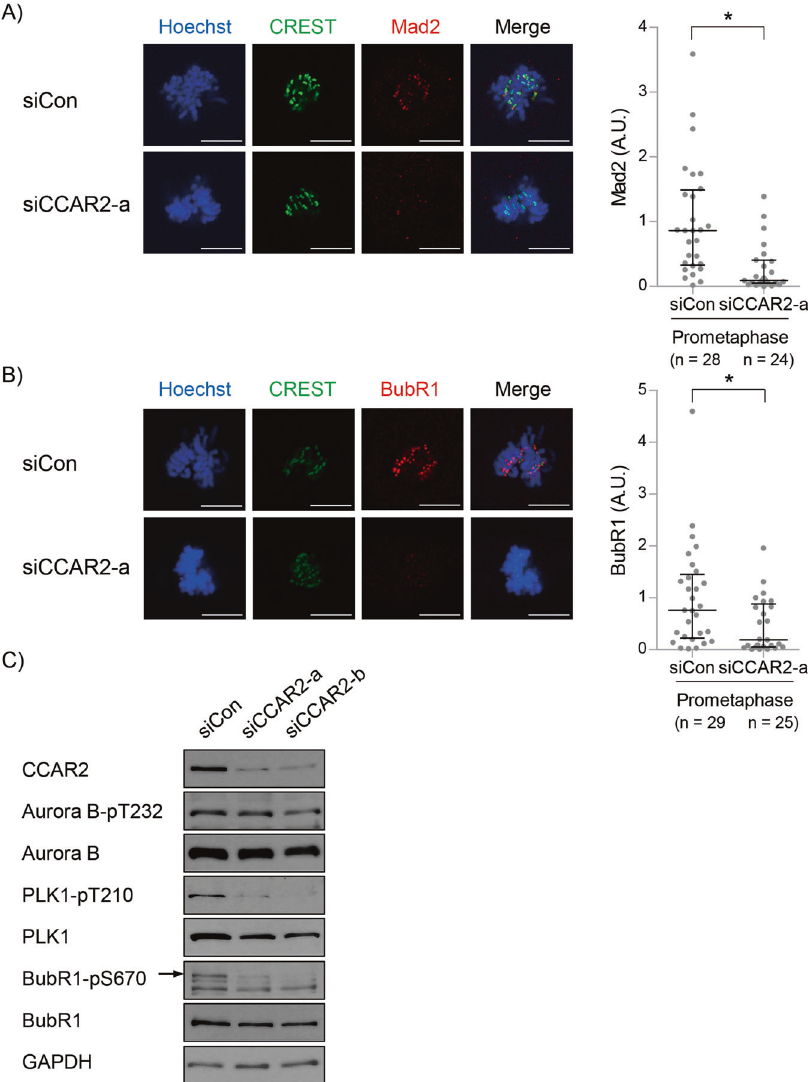
Fig. 5 CCAR2 de fi ciency induces inactivation of spindle assembly checkpoint. A , B Asynchronous A549 cells were stained with Hoechst, CREST, and anti-Mad2 or anti-BubR1 antibodies. Fluorescence intensity of kinetochore-associated Mad2 (A) or BubR1 (B) in siCCAR2-a cells was normalized to that of siCon at prometaphase. The number of prometaphase in all experiments ( n ) was presented in each graph. The fi rst and third bars are the 25th and 75th percentiles, respectively, and the second bar is the median. * p < 0.05, signi fi cantly different from corresponding siCon cells (Mann – Whitney U test); A.U., arbitrary units; scale bar, 10 μ m. C Cells were arrested at the G1/S boundary by double thymidine block and then released for 9 h. MG132 (30 μ M) was treated for the last three hours to block anaphase onset. The amount of each protein was determined by western